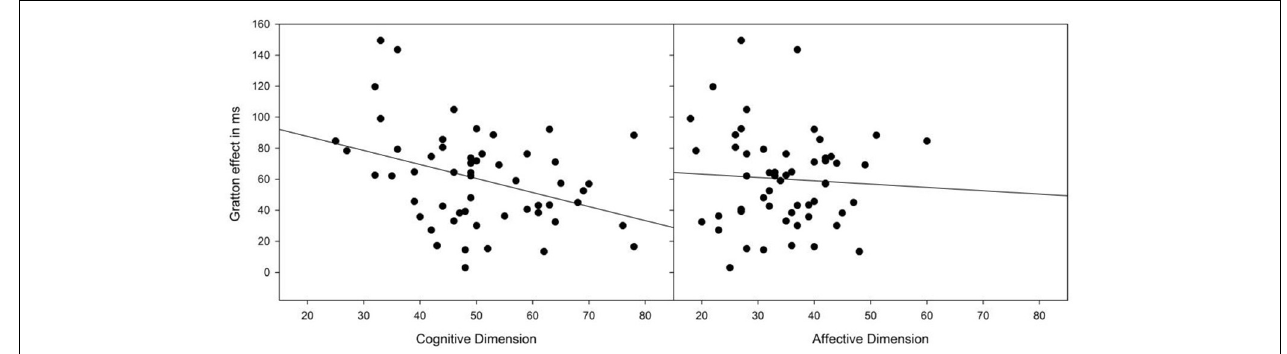
FIGURE 1 | Scatterplots of the Gratton effect against BVAQ scores for the cognitive and affective dimensions. The BVAQ cognitive, but not the affective dimension predicts the degree to which people adapt their cognitive control to task demands, as measured by the Gratton effect.